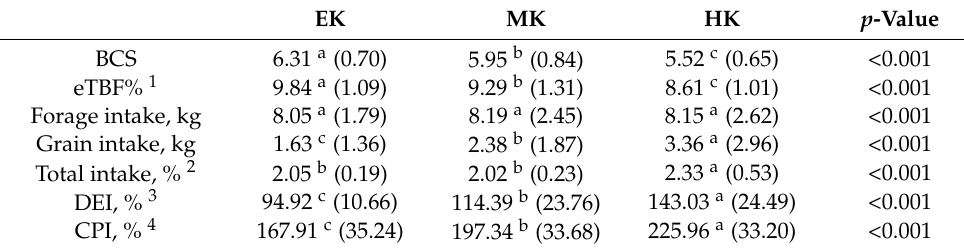
Table 2. Diet composition means of EKSS assignments ( n =